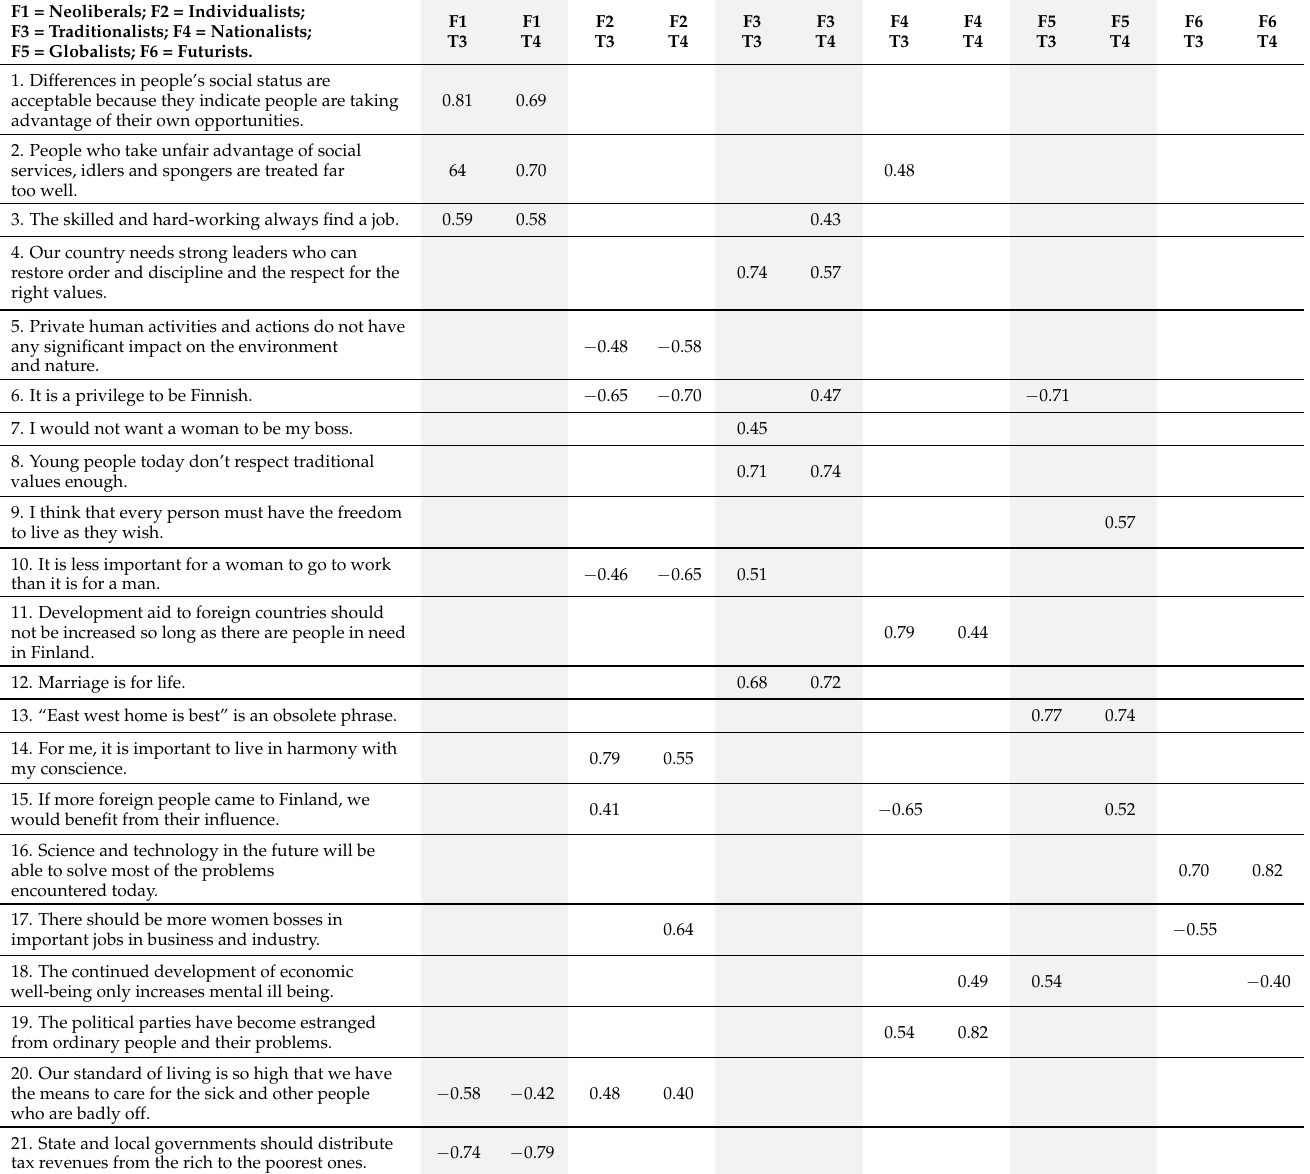
Table 2. Millennials: Factors and loadings in the six-factor solution in 2011 (T3) and 2015 (T4). The factor analysis comprised for Millennials six factors (see Table 2). F1 Neoliberals contained five items that explained 23% of the total variance with factor loadings from − 0.42 to 0.81. F2 Individualists comprised six items that explained 11% of total variance in T3 and 10% in T4 with loadings from 0.40 to 0.79. F 3 included seven items from loadings 0.43 to 0.74 explaining 9% of total variance in T3 and 8% in T4. F4 Nationalists comprised five items with loadings from 0.44 to 0.79 that explained 7% of the total variance in T3 and T4. F5 Globalists accounted for 7% of the total variance in T3 and T4 from 0.52 to 77 loadings. F6 Futurists comprised three items with loadings from − 0.55 to 0.82 explaining 6% of the total variance in T3 and 5% in